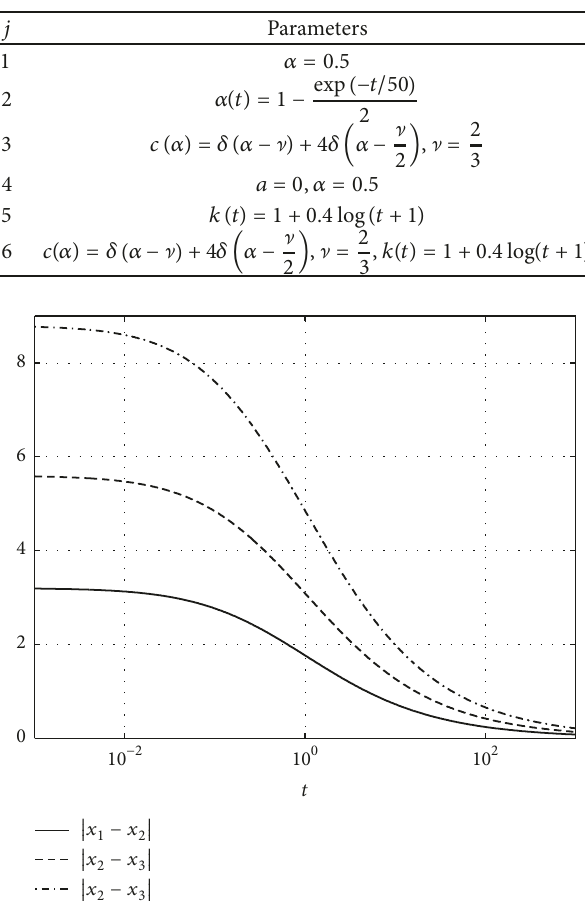
Table 1: Differential orders for simulations.